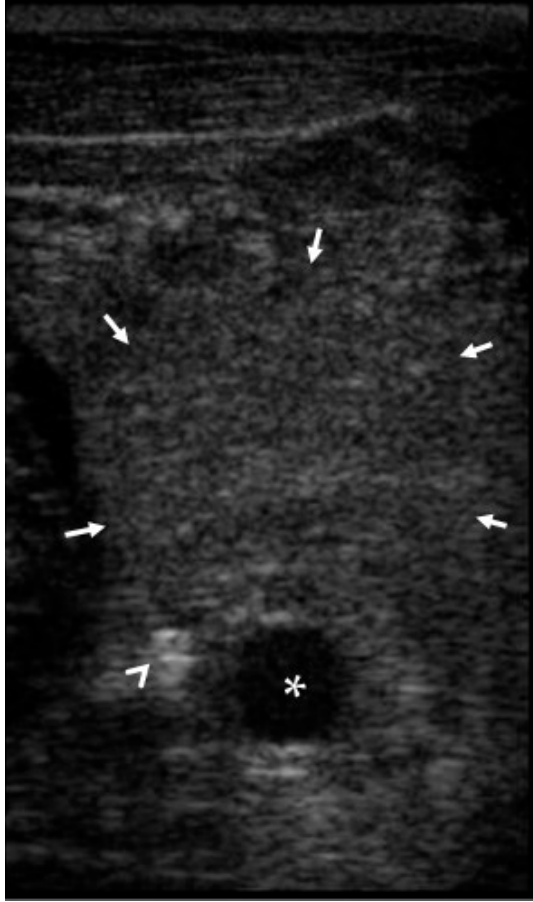
Figure 6. Case 2. Ultrasound showing a perivascular haematoma (delimited by arrows) around common carotid artery (asterisk). Angio-seal anchor (arrowhead) appears to be outside of the arterial lumen.